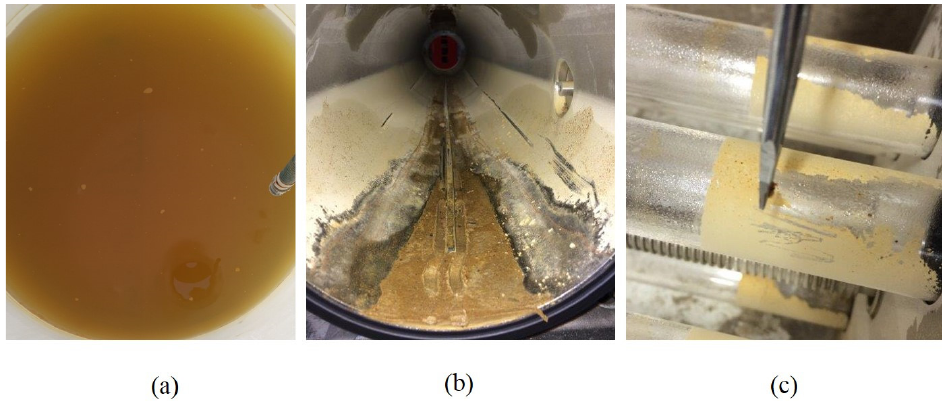
Figure 3. Challenges caused by dissolved iron and others: ( a ) picture taken from the HDPE reservoir; ( b ) picture taken from the UV chamber; ( c ) picture taken from the protection sleeve of UV lamps.